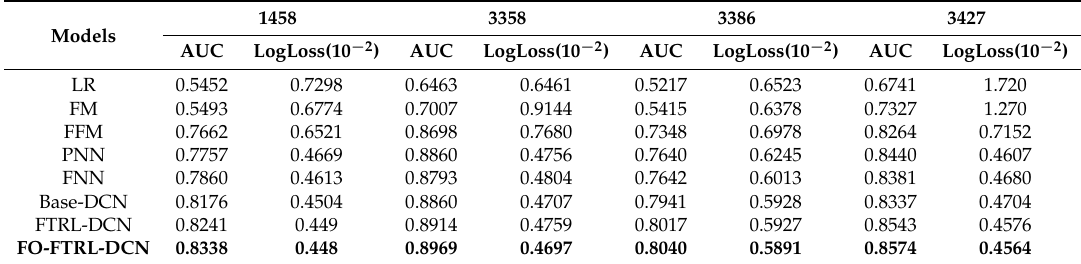
Table 2. The comparison between the proposed model and classical models on four datasets.